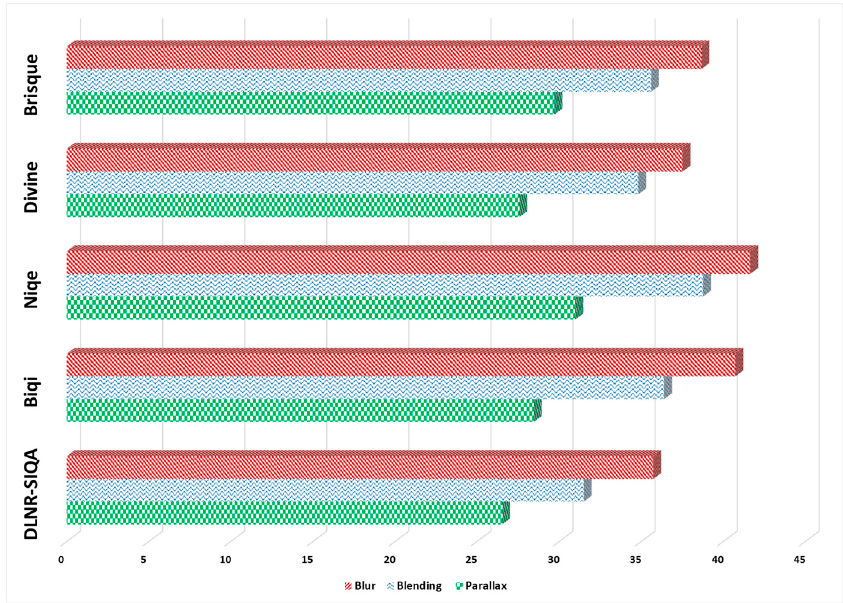
Figure 10. Dominancy analysis of three different stitching errors for panoramic image quality assessment.